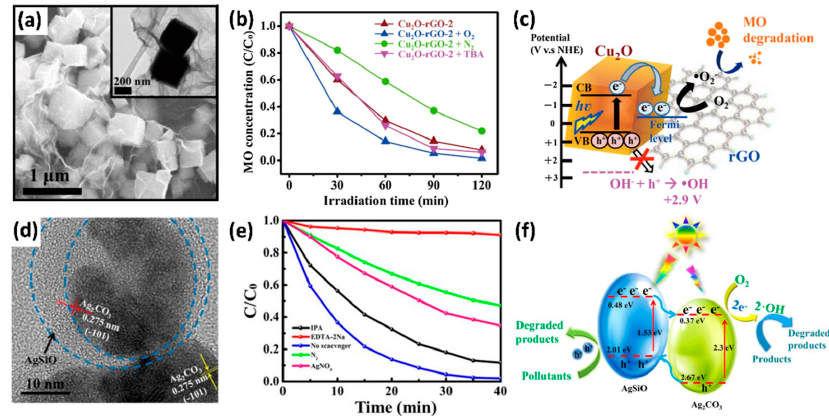
Figure 16. ( a ) SEM and TEM (inset) observations and ( b ) MO photodegradation over Cu 2 O–rGO under different experimental conditions. ( c ) Schematic illustration of the band structure and relevant redox potentials for Cu 2 O–rGO (reproduced with permission from [84] . Copyright Elsevier Science Publishers, 2015.). ( d ) High-resolution (HR) TEM image of AgSiO/Ag 2 CO 3 . ( e ) MB photodegradation under visible irradiation in the presence of scavengers and ( f ) proposed mechanisms of photodegradation pathways of MB on AgSiO/Ag 2 CO 3 (reproduced with permission from [90] . Copyright Nature Publishing Group, 2017.). Table 3. Active species for photodegradation of commonly reported dyes molecules.